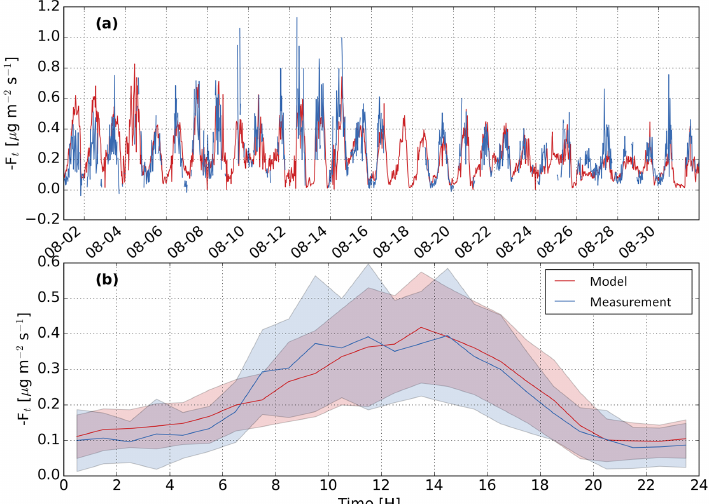
Figure 6. (a) Time series of the simulated (red) and measured (blue) O 3 turbulent fluxes above the canopy in August 2010. (b) The monthly averaged diurnal cycles of time series presented in (a) for the model (red) and measurement (blue). The ranges of ± 1SD are marked by the shades with the same colours. Positive values represent downward fluxes.